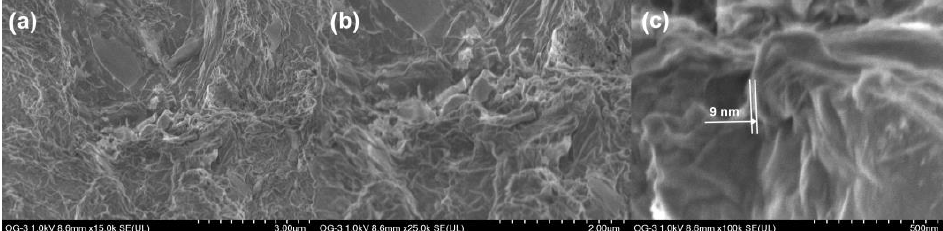
Figure 7. SEM image of GO60 sheets ( a ) ×15,000, ( b ) ×25,000 and ( c ) ×100,000. Network thickness of graphene oxide layers of ≈ 6 nm on average. Figure 8. SEM image of GO90 sheets ( a ) ×15,000, ( b ) ×25,000 and ( c ) ×100,000. Network thickness of Figure 8. SEM image of GO90 sheets ( a ) × 15,000, ( b ) × 25,000 and ( c ) × 100,000. Network thickness graphene oxide layers of ≈ 9 nm on average. of graphene oxide layers of ≈ 9 nm on